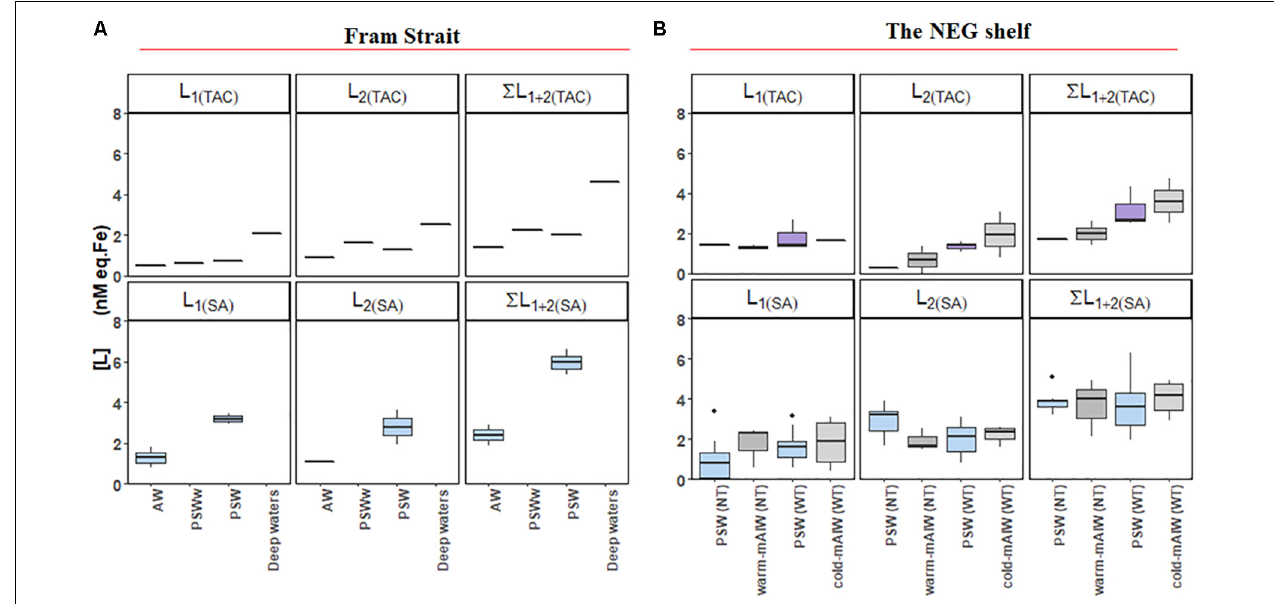
FIGURE 5 | Boxplot of the results from a two-ligand model: ligand concentrations of the strong ligand group [L 1 ], and the relatively weak ligand group [L 2 ], together with the sum of [L 1 ] and [L 2 ] from samples (A) from Fram Strait and (B) from the northeast Greenland shelf. The details of the boxplot are described in Figure 2 .